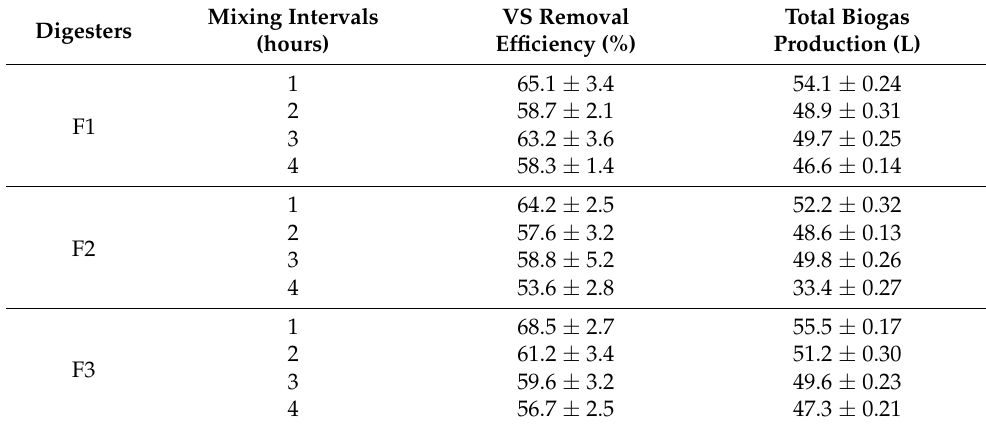
Table 4. Represents the total VS reduction (%) in all the digesters at various mixing intervals.